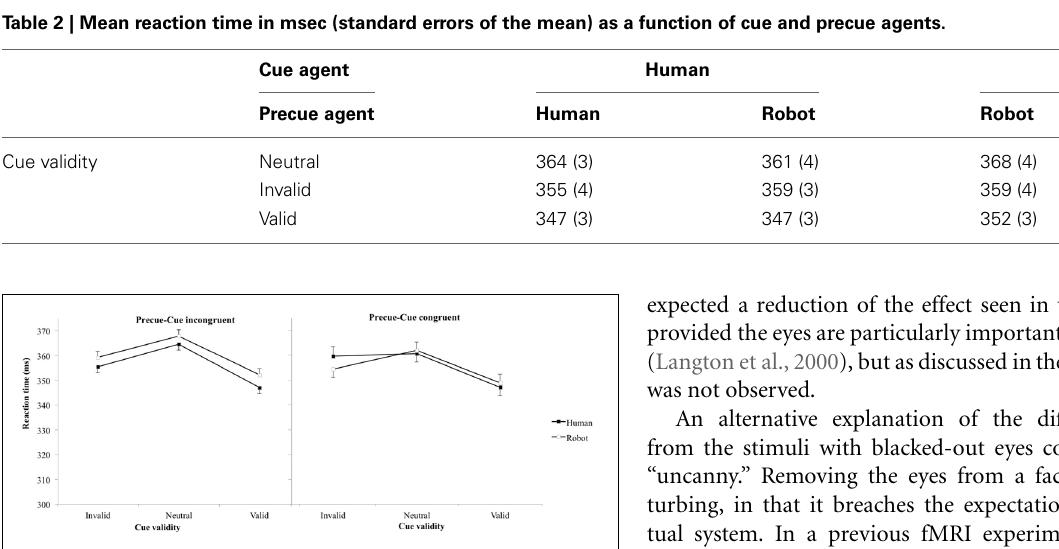
FIGURE 3 | Reaction time (error bar: standard errors of the means) plotted against cue validity for human and robot cues when pre-cue and cue stimuli are congruent (left) and incongruent